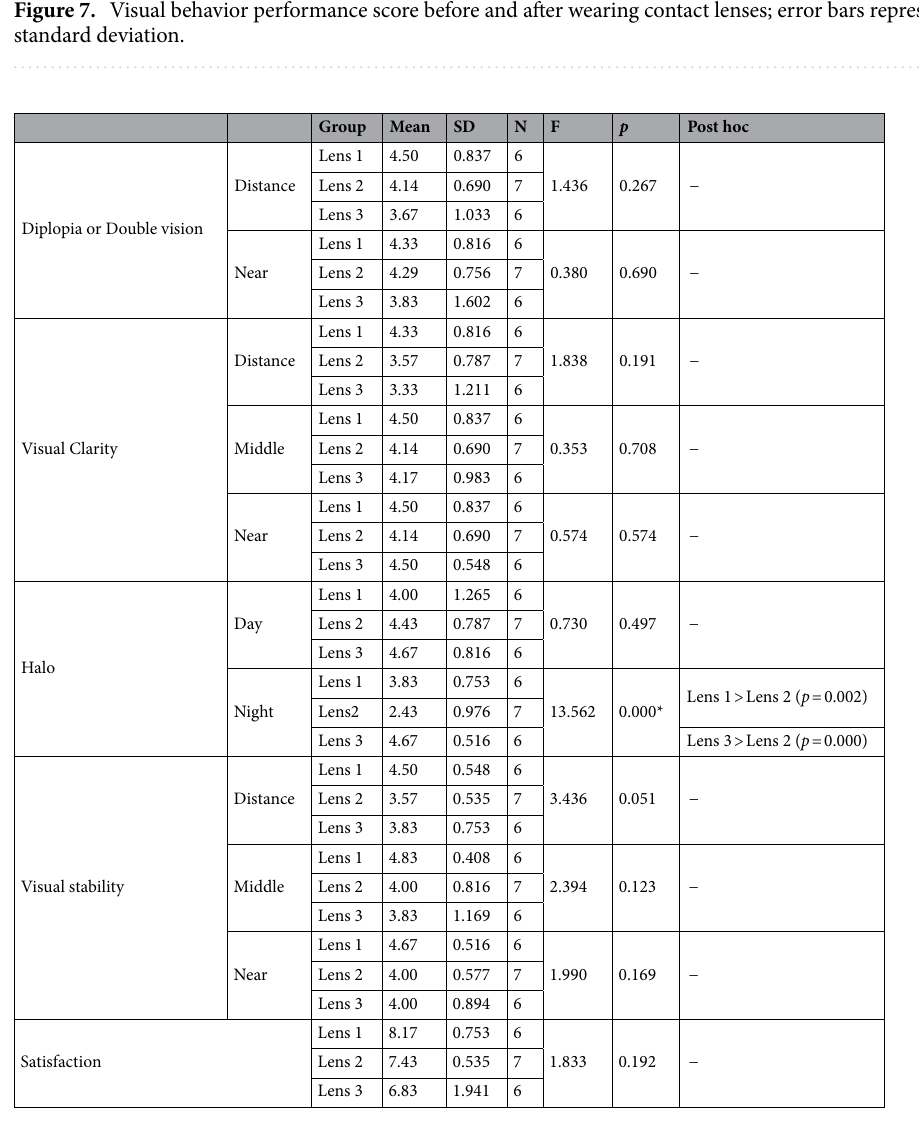
Table 3. Effects of the three contact lenses on visual